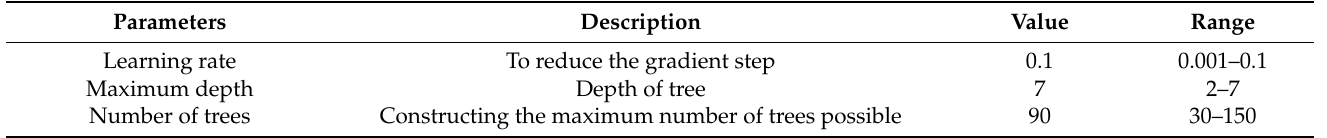
Table 1. Tuned or optimized hyperparameters of RF regression.